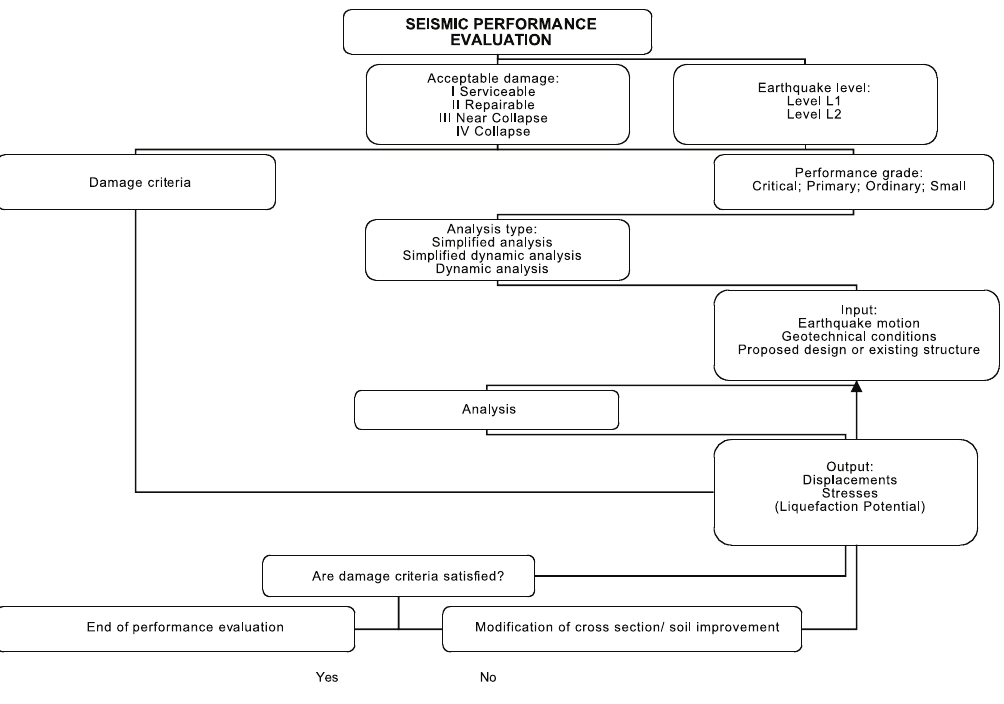
Fig. 11. Steps required for the seismic behaviour analysis of a geotechnical structure using a performance-design based approach (modified after International Navigation Association,